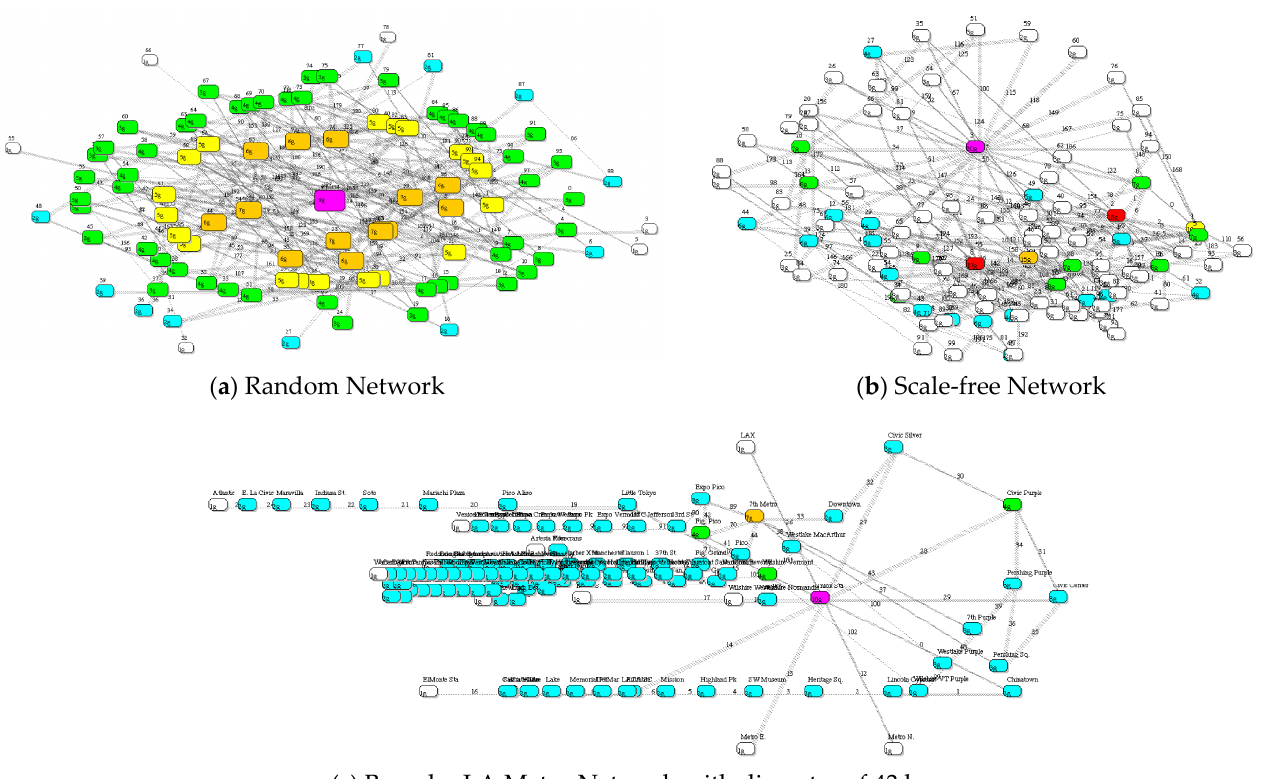
Figure 4. ( a ). Random structure with 100 nodes and 197 links; spectral radius = 4.66, branchy = 2.58. ( b ). Scale-free network with 100 nodes and 197 links: spectral radius = 7.18, branchy = 0.84. ( c ). Branchy LA Metro network with 117 nodes and 127 links: spectral radius 3.69, Branchy 11.65. It is the recognition that structure matters, illustrated in this paper, that partially determines risk and resilience. Nodes are heat map colored to indicate connection